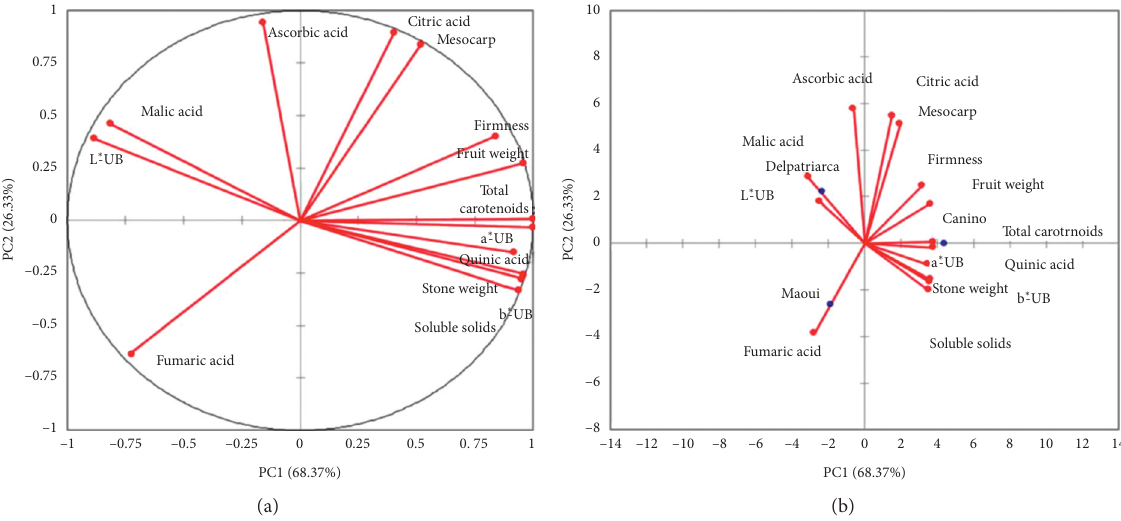
Figure 2: Biplots based on principal components analysis (PCA) for fruit quality attributes. (a) Correlation circle between physical parameters (fruit and stone weight, mesocarp percentage, Un-Blush skin color parameters (L ∗ -UB, a ∗ -UB, and b ∗ -UB), and firmness) and biochemical parameters (total soluble solids content, total carotenoids, and malic, citric, ascorbic, quinic, and fumaric acids). (b) Segregation of three cultivars according to their quality characteristics determined by